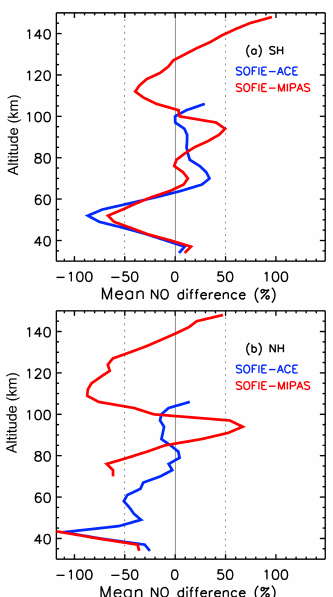
Figure 9. Mean NO differences versus height for comparisons of SOFIE with ACE and MIPAS in the (a) SH (SOFIE sunset) and (b) NH (SOFIE sunrise). The mean differences are as shown in Figs. 6 and 7. Mean NO and NO differences are only shown when there were more than 30 points in the